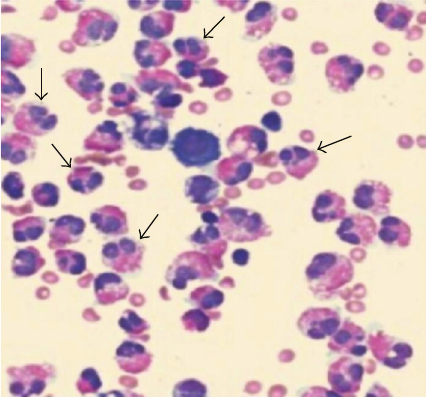
Figure 2: Ascitic fluid showing increased numerous eosinophils (arrows) with Giemsa stain (original magnification × 600).